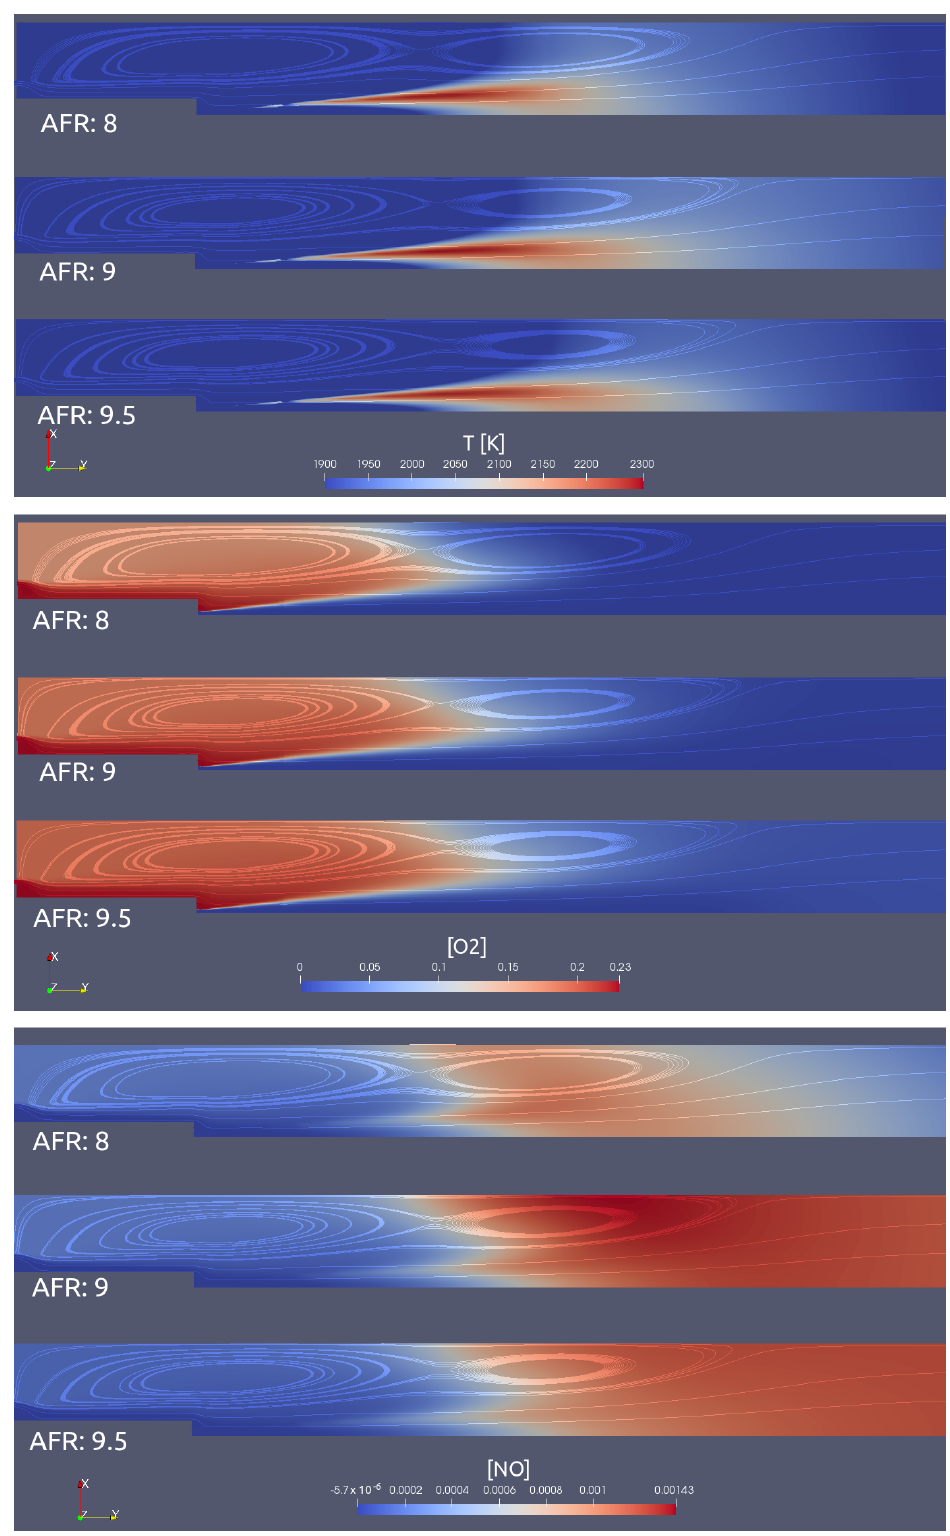
Figure 14. Contour plot of the temperature, and the mass fractions of oxygen and thermal NOx respectively for three different air–fuel ratio’s from fuel-rich mixture (AFR 8) to stoichiometric mixture (AFR 9.5). The minimum temperature is deliberately set at 1900 K to highlight the critical areas where thermal NOx can potentially be